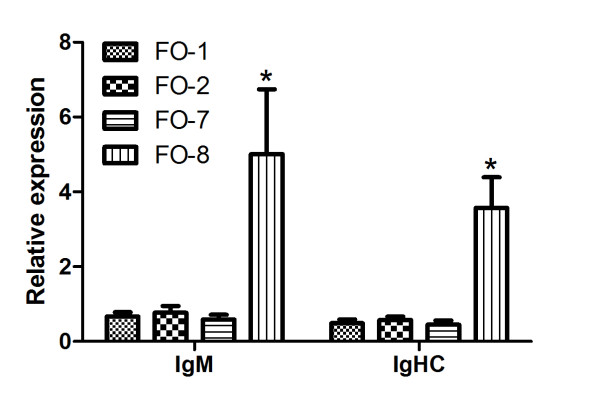
Immunoglobulin genes expressed in the head kidney of Atlantic salmon injected with different oil-based vaccines. qPCR expression studies of IgM and immunoglobulin heavy chain constant region (IGHC) genes identified as upregulated by microarray. FO-1 = A. salmonicida (sc); FO-2 = A. salmonicida (6 × sc); FO-7 = M. viscosa (sc); FO-8 = M. viscosa (6 × sc). Gene expression ratios normalized to EF1α. Error bars = SE, n= 7. *p < 0.05.